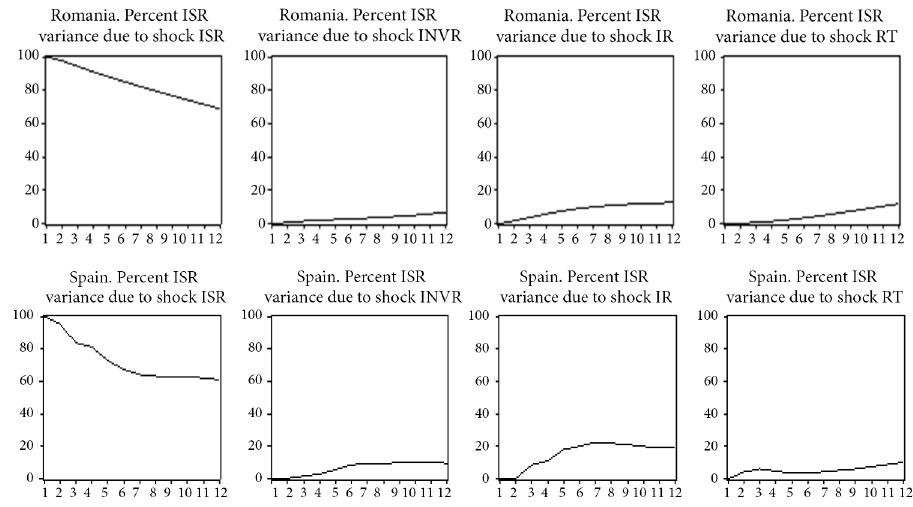
Figure 3. Variance